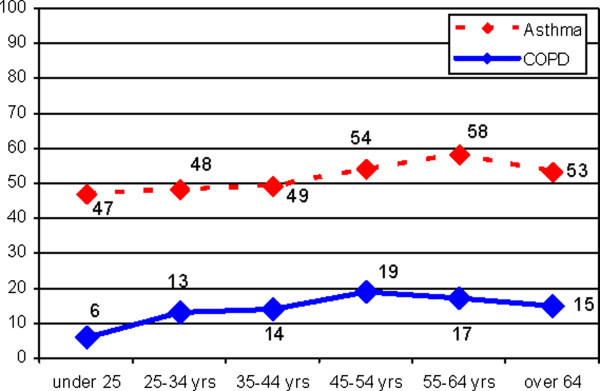
Awareness by age.